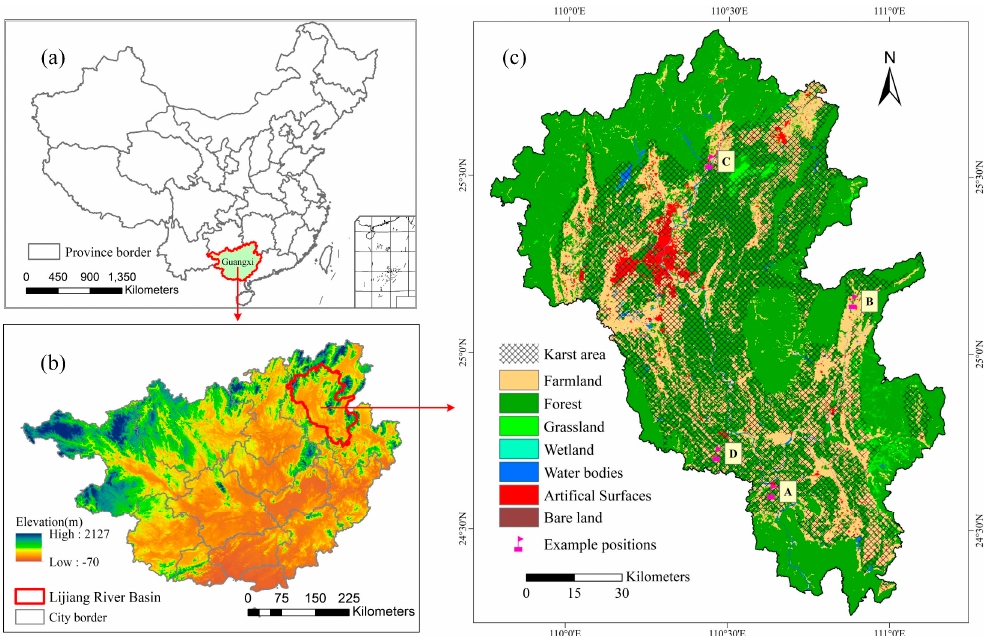
Figure 1. Location of the Lijiang River Basin. ( a ) Map of Chinese provincial districts. ( b ) Map of Guangxi Zhuang Autonomous Region. ( c ) Land use map of Lijiang River Basin.